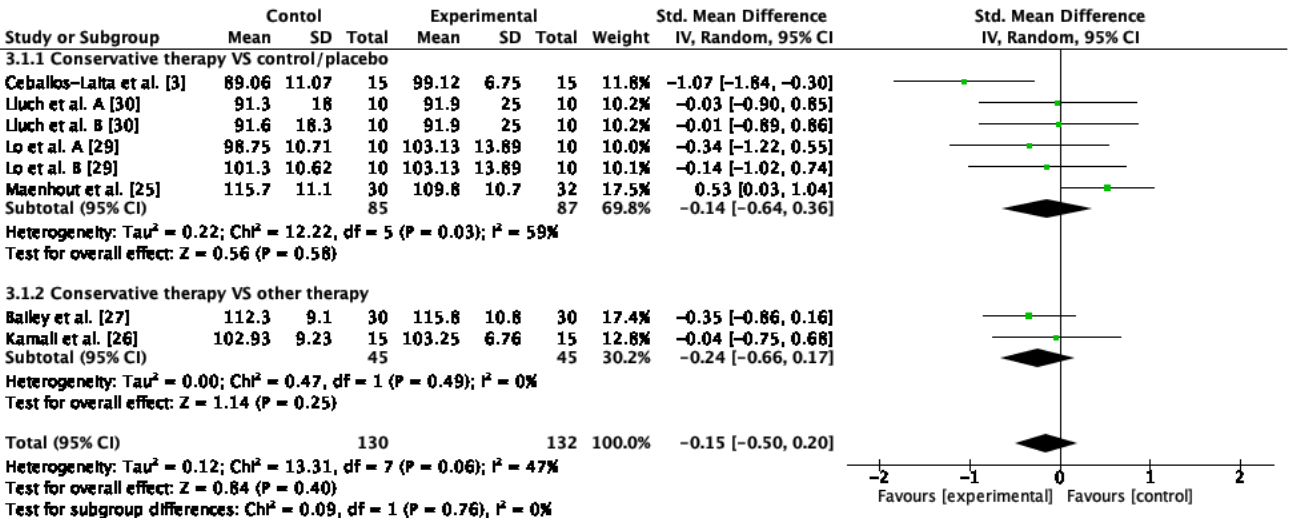
11 of 22 Figure 3. Forest plot of internal rotation ROM for conservative therapy versus control/sham and combination of conservative therapies versus conventional therapy in isolation. Lluch et al. A. com- pared manual therapy versus control intervention. Lluch et al. B compared the manual contact ver- sus control intervention. Lo et al. A compared KT versus control intervention. Lo et al. B compared stretching versus control intervention. 3.4.2. External Rotation ROM The external rotation ROM was measured in six studies [21,25 – 27,29,30], which were included in the quantitative synthesis and meta-analysis for the external rotation ROM.